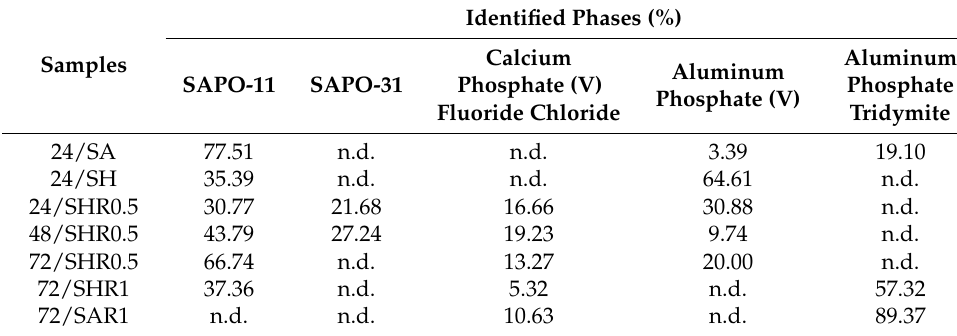
Figure 3. XRD patterns of samples by using phosphor powder ( a – c ) (S = SAPO-11) and SEM images of the 24/SHR0.5 ( d ), 48/SHR0.5 ( e ); 72/SHR0.5 ( f ). Table 4. Identified Phases by Rietveld refinement.